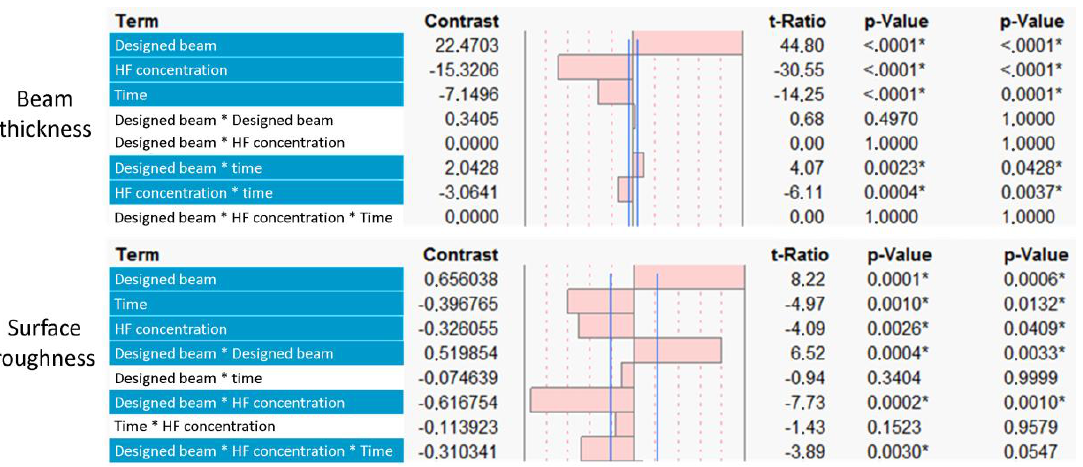
Figure 2. Multi-level factorial analysis of the main effects of the experimental factors [designed beam thickness, hydrofluoric acid (HF) concentration and surface treatment time] on the output variables (final beam thickness and surface roughness). The threshold of statistical significance is indicated by the vertical lines and was set at p < 0.1.